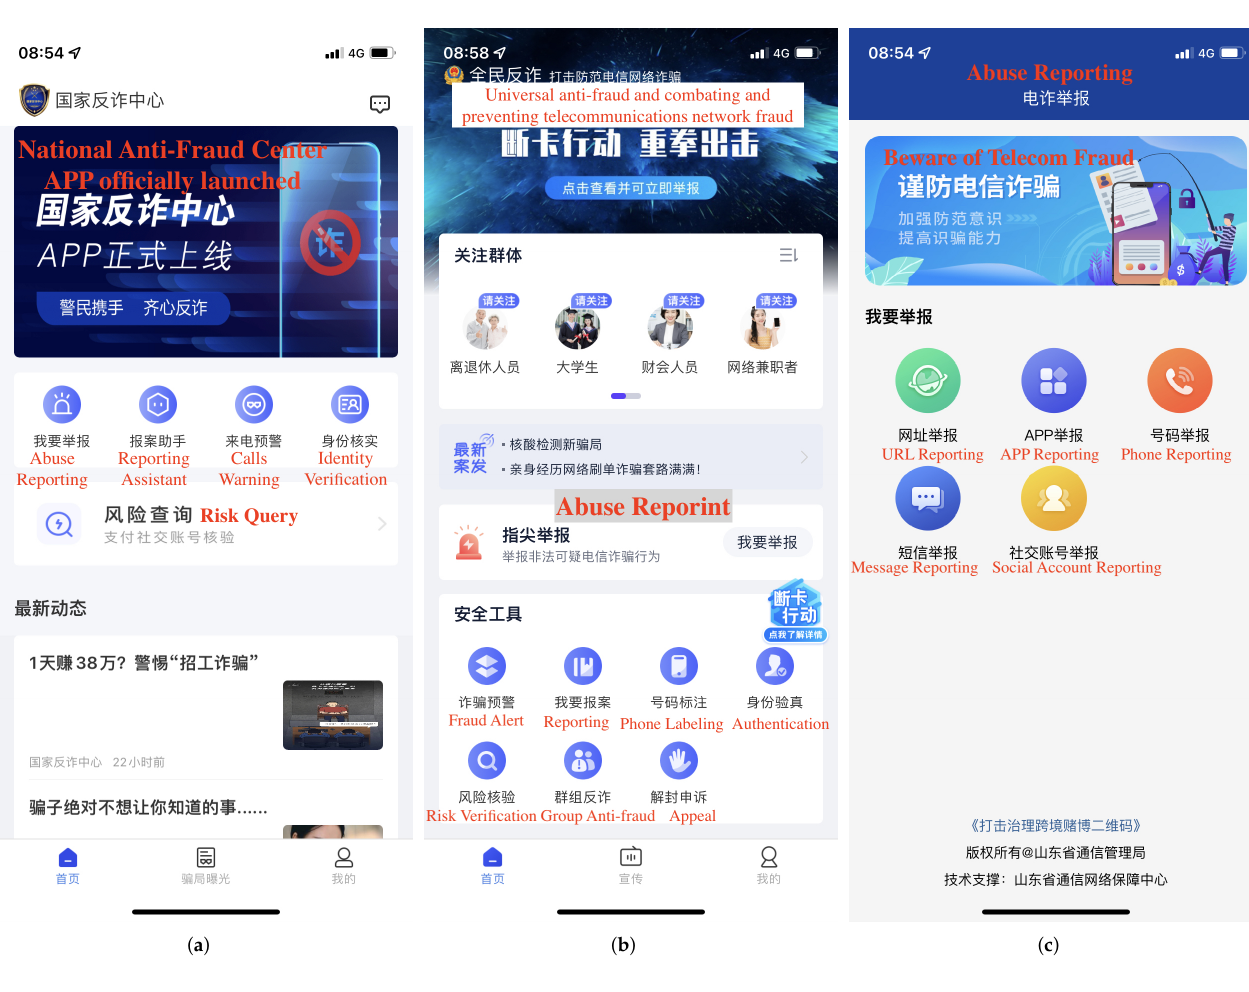
Figure 5. Reporting platform in the form of an App. ( a ) National Anti-Fraud Center. ( b ) Beijing Anti-Fraud Center. ( c ) Shandong Anti-Fraud